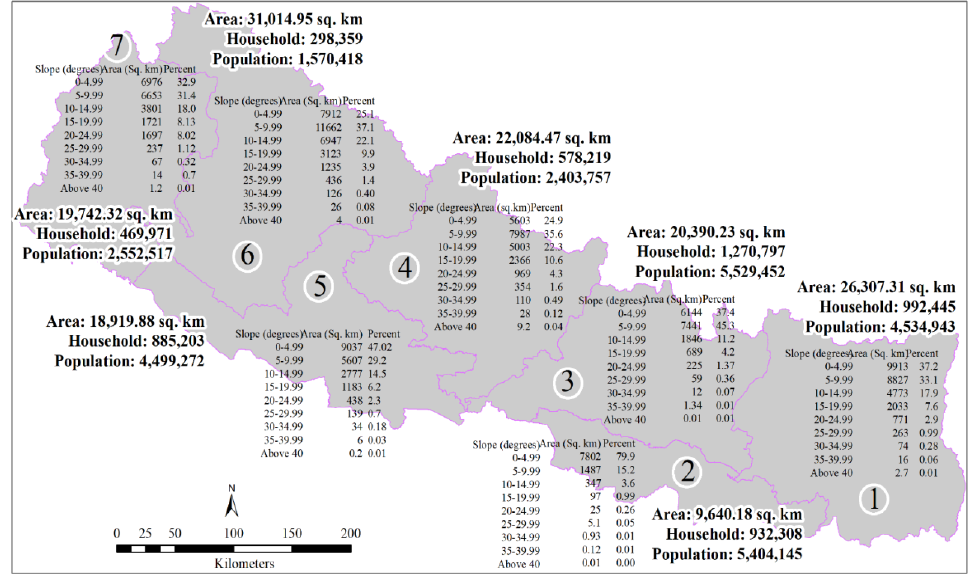
Figure 8. Land areas (sq. km) by 9 slope classes, total area, household, and total population within 7 provinces of Nepal. [Note: There is a discrepancy of 37.8 sq. km between the sum of the total areas of 7 provinces and the total area of Nepal. It is due to the conversion of (30 m × 30 m cell size multiplied by 900 and divided by 1,000,000 to convert into square kilometers].